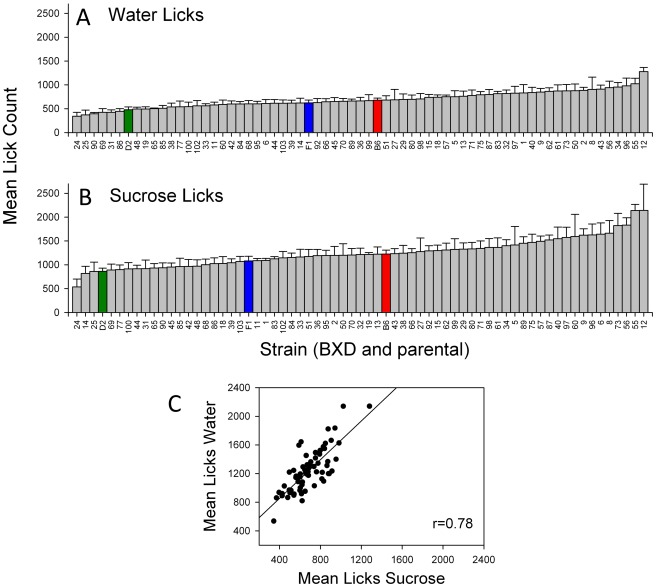
Histograms for mean (± SE) number of licks across all BXD, parental, and F1 strains.A. Licks to water. B. Licks to sucrose. Green, blue, and red bars denote values for D2, F1 and B6, respectively. C. Scatter plot of strain averages for water MPI and sucrose MPI.